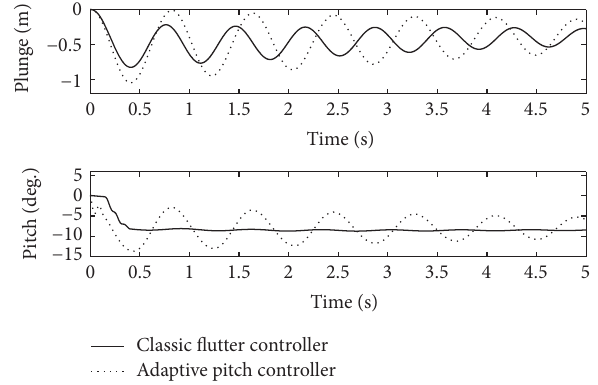
Figure 8: System responses with classic flutter controller and adaptive pitch controller at deep flutter case.